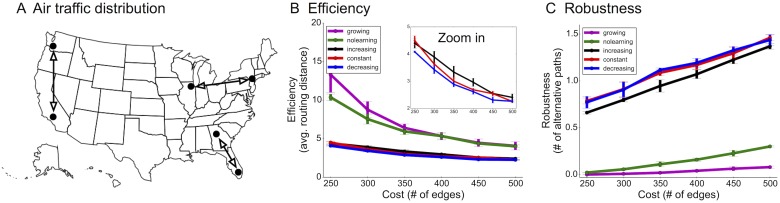
Improving airline efficiency and robustness using pruning algorithms.(A) Actual data of travel frequency amongst 122 popular cities from the 3rd quarter of 2013 was used to define a source-target distribution. (B-C) Efficiency (travel time in terms of number of hops) and robustness (number of alternative routes with the same number of hops) comparison using different algorithms. Decreasing-rate pruning produced more efficient networks with similar robustness.